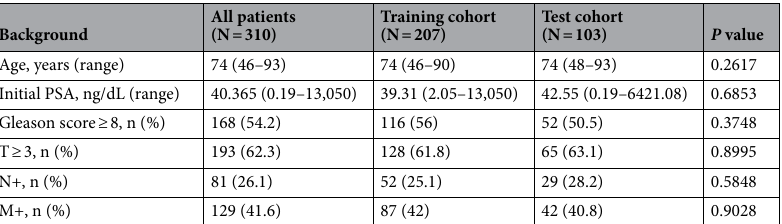
Table 1. Clinical backgrounds of 310 patients with prostate cancer. T ≥ 3 means tumor stage 3 or greater, N+ means lymph node metastasis, M+ means metastasis.